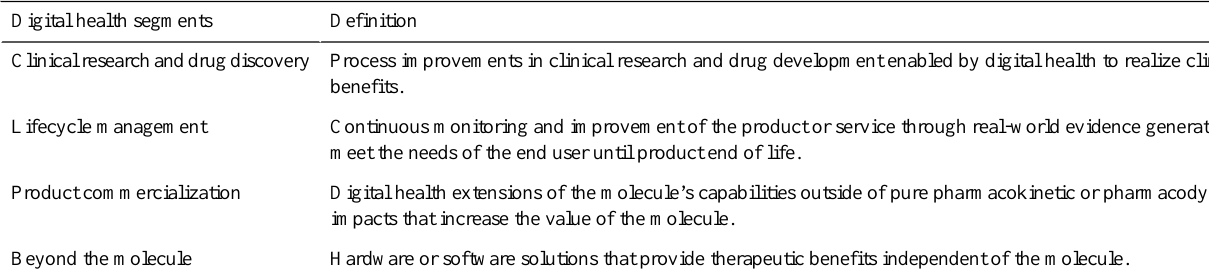
Table 1. Four digital health segments used to evaluate biopharmaceutical company